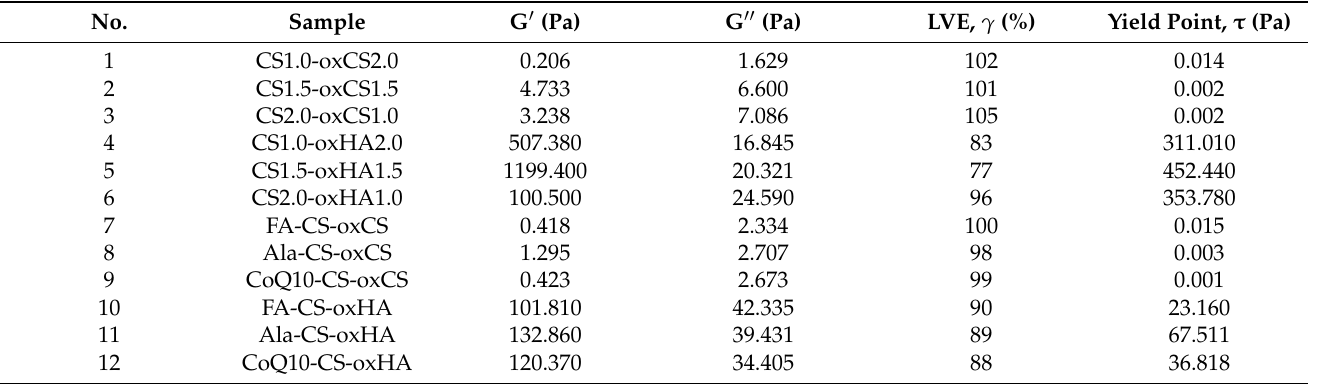
Table 6. The amplitude sweep parameter values recorded for CS-oxCS/oxHA and API-CS- oxCS/oxHA